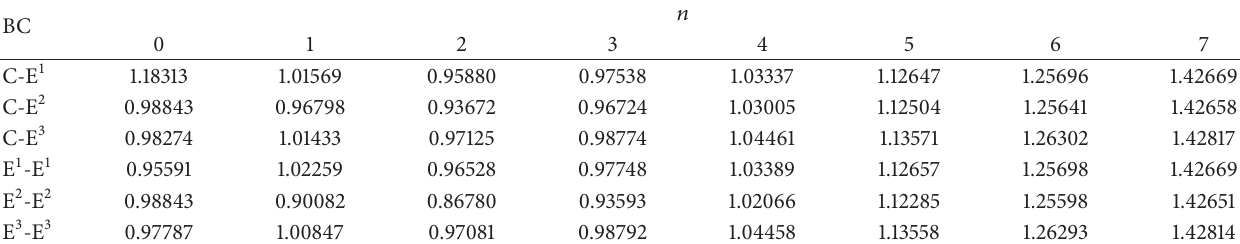
Table 22: First several frequency parameters Ω = 𝜔𝑅√𝜌(1 − 𝜇 2 )/𝐸 for a closed spherical shell with various elastic restraints ( 𝑚 = 1